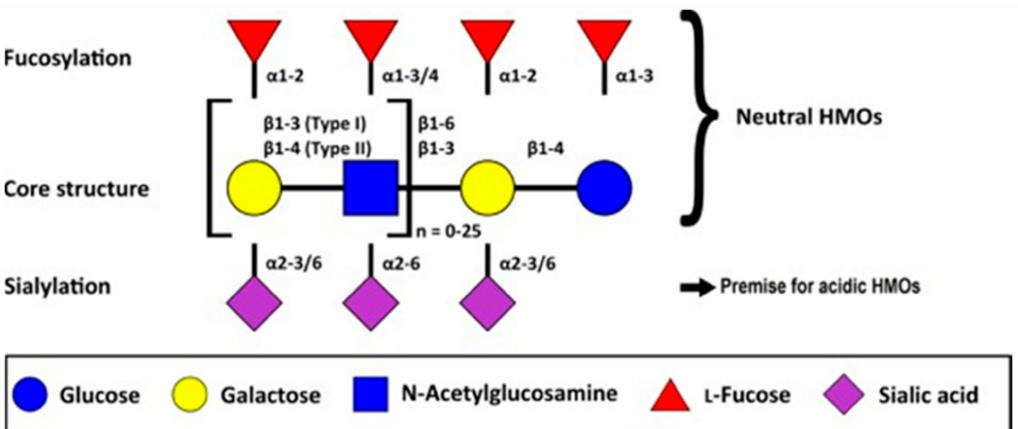
Figure 3. Basic structures of Human Milk Oligosaccharides (HMOs). The core HMO structures are shown in yellow and blue in the center of the figure. The upper panel shows fucosylated HMOs, and the lower panel shows sialylated ones. The building blocks are shown in the lowermost part of the figure